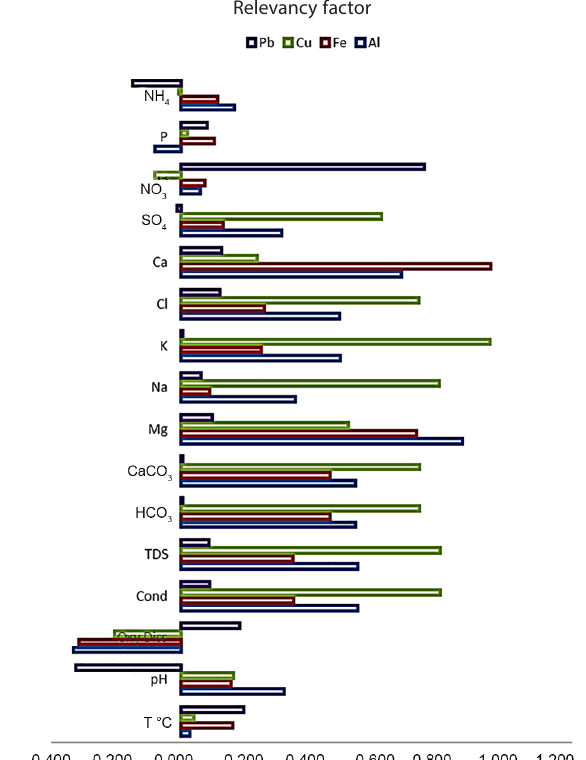
Figure 6. The relevancy factor between independent